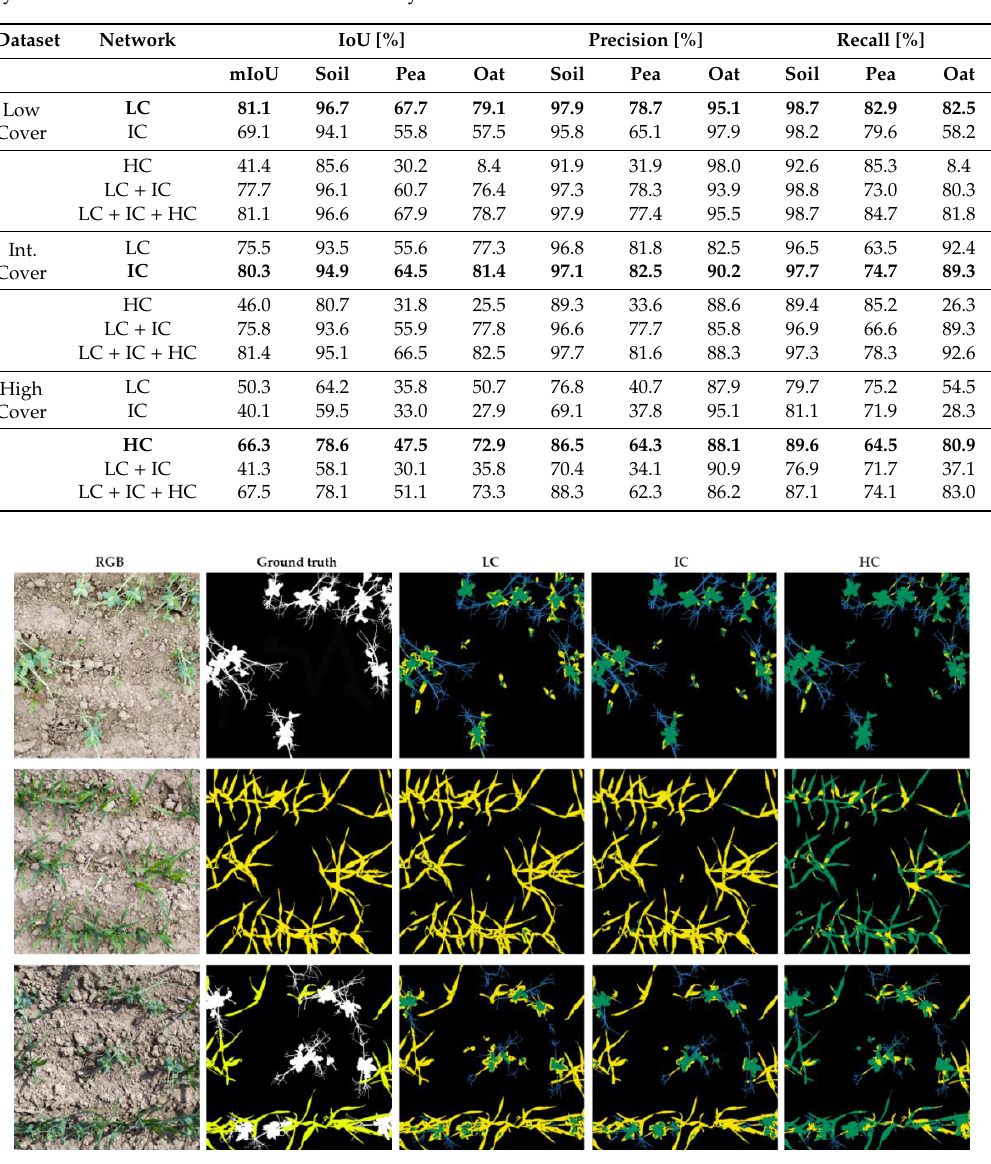
Table 3. Intersection over union (IoU, %), precision (%), and recall (%) for pea, oat, and soil for the three evaluation datasets (low cover—LC, intermediate cover—IC, and high cover—HC) each analyzed by the five di ff erent networks. Individually trained networks in bold.